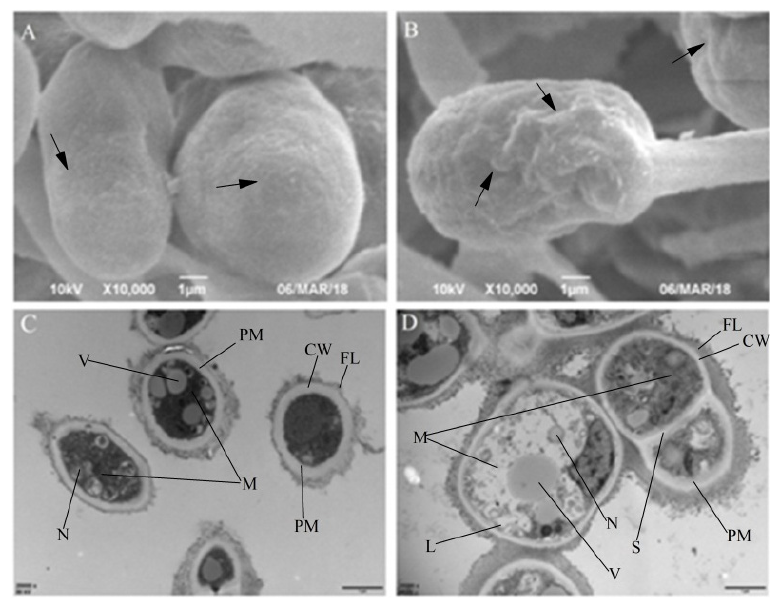
Figure 3. Morphological (A: control, and B: treatment under scanning electron microscopy) and ultrastructural (C: control, and D: treatment under transmission electron microscopy) changes of T. roseum conidia upon cuminal exposure. (CW: cell wall, FL: fibril layer, PM: plasmalemma, M: mitochondrion, S: septum, V: vacuole, N: nucleus, L: lomasome).